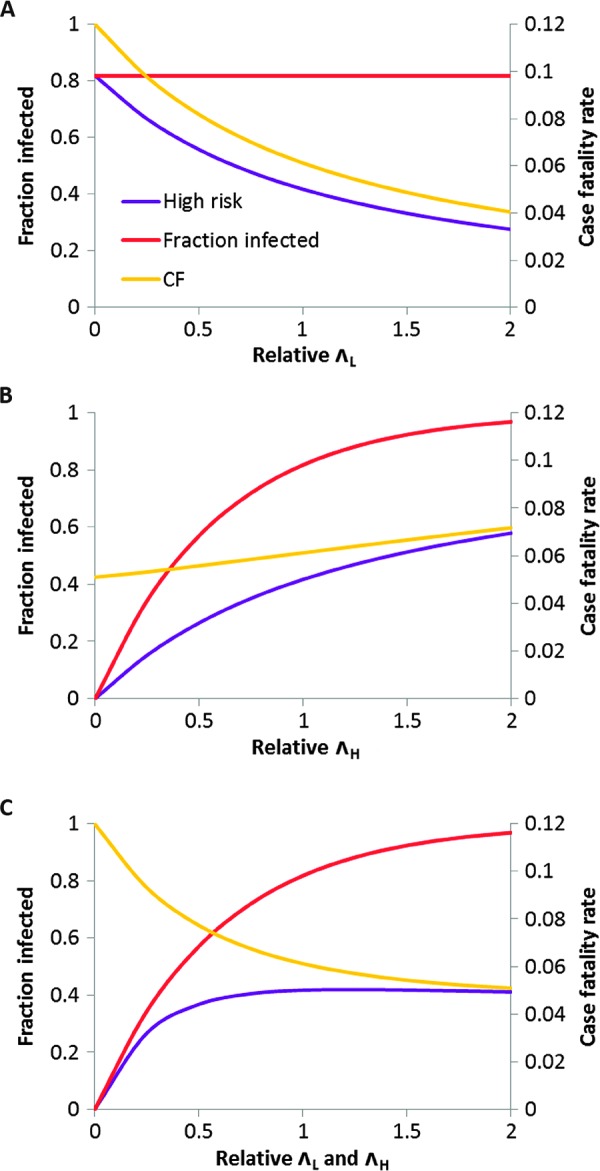
Modeling the effect of LPT infections on clinical burden due to T. parva.(A) Model outputs for scenario A, changing the force of infection for LPT species, ΛL (relative to baseline, scaled to 1 on horizontal axis), but not changing ΛH. Baseline parameter values are as in Table 3. Fraction of calves infected with T. parva before 1 year old (unchanged), high-risk infections only, and overall case fatality rate are shown. (B) Same outputs for scenario B, changing the force of infection for T. parva, ΛH, but not changing ΛL. (C) Same outputs for scenario C, changing both ΛH and ΛL. In contrast to scenario B, there is minimal change in the fraction of calves at high risk over a fourfold change (from 0.5 to 2) in relative forces of infection for this set of parameter values.